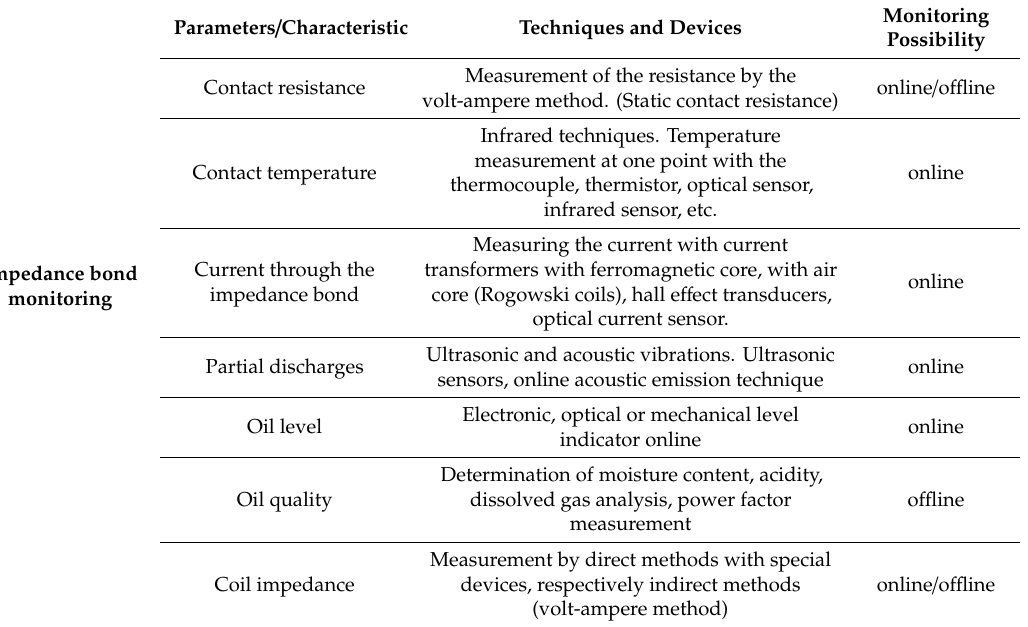
Table 1. Parameters and techniques for monitoring and diagnosing of the impedance